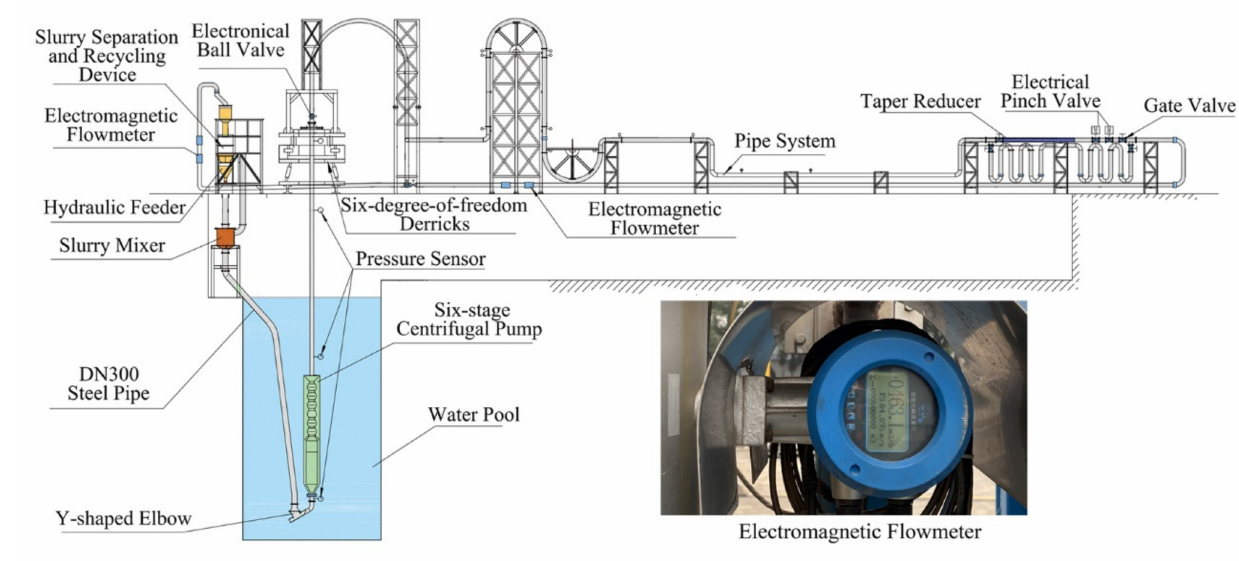
Figure 6. Experimental system layout.